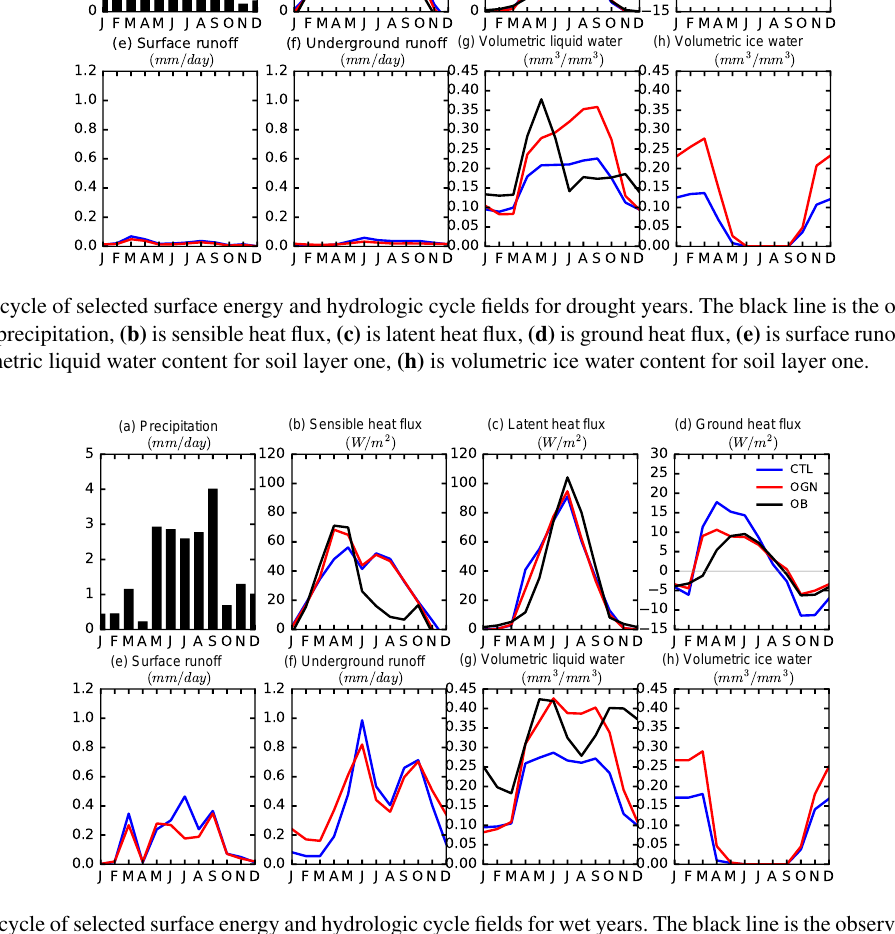
Figure 11. Annual cycle of selected surface energy and hydrologic cycle fields for wet years. The black line is the observation. Note that (a) is the observed precipitation, (b) is sensible heat flux, (c) is latent heat flux, (d) is ground heat flux, (e) is surface runoff, (f) is underground runoff, (g) is volumetric liquid water content for soil layer one, (h) is volumetric ice water content for soil layer